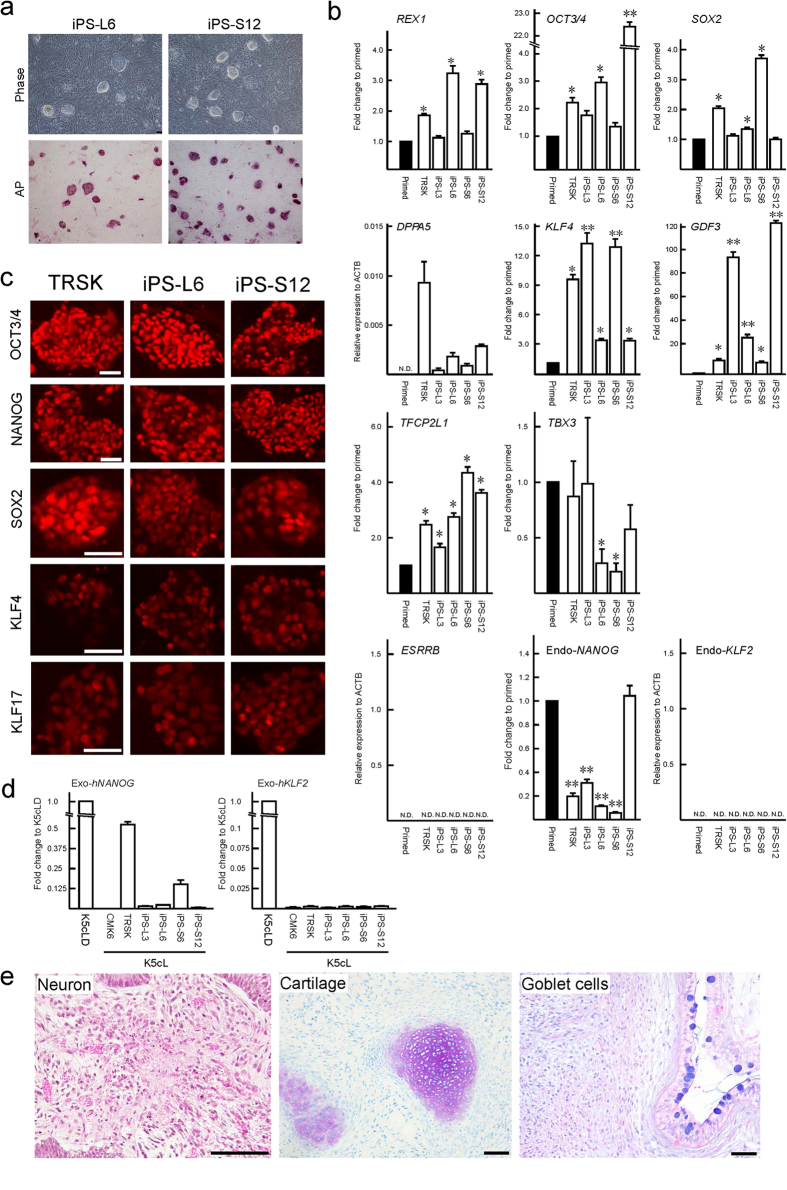
Naïve-like conversion of Cm iPSC lines.(a) Phase contrast images (Phase) and the alkaline phosphatase activity (AP) signals of naïve-like Cm iPSCs. (b) RT–qPCR for naïve pluripotency-related transcripts before (closed bars: primed) and after (open bars: naïve-like) naïve-like conversion of a Cm ESC line, TRSK, and iPSC lines. Expression levels before (primed) and after naïve-like conversion of each cell line are standardized to 1.0. DPPA5 and endo-KLF2 indicate the relative expression level of ACTB (α-actin). Error bars indicate the S.D. *P < 0.05; **P < 0.01. (c) Immunocytochemical analysis of PSC lines (TRSK, iPS-L6, and iPS-S12) that had converted into a naïve-like state, using antibodies directed against markers of naïve pluripotency related proteins. (d) Relative expression of Exo-hNANOG and Exo-hKLF2 in the presence (K5cLD medium) and in the absence (K5cL medium) of Dox. (e) Teratoma formation of a naïve-like converted iPSC line, iPS-S12. Various tissues of the three germ layers are identified: neurons stained with HE (ectoderm), hyaline cartilage stained with Toluidine blue (mesoderm), and goblet cells stained with Alcian blue (endoderm). Scale bar = 100 μm.